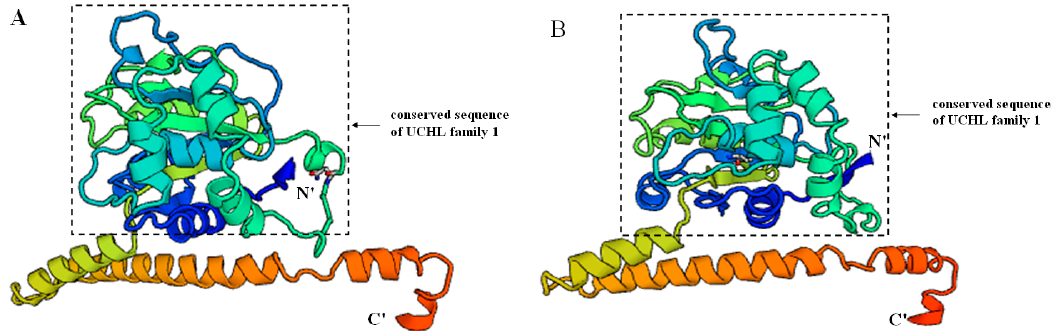
Figure 4. The predicted three-dimensional structure of Sp -UCHL5 ( A ) and Ha -UCHL5 ( B ).